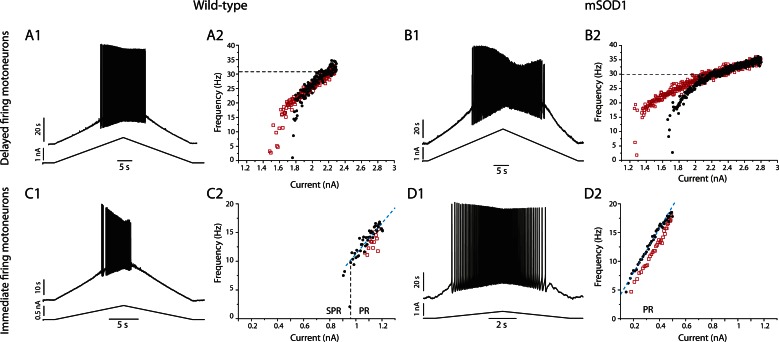
Responses of a delayed firing motoneuron (upper row) and of an immediate firing motoneuron (lower row) to a slow current ramp.Same motoneurons as in Figure 7. (A1–A2) WT delayed firing motoneuron. (A1) Bottom: injected-current (slow triangular ramp at the 0.1 nA/s velocity) and top: voltage-response. (A2) F–I curves for the ascending (black dots) and descending ramps (red squares). Note that the recrutement current occurs at higher intensity than the de-recruitment current. (B1–B2) mSOD1 delayed firing motoneuron. In A2 and B2 the dashed horizontal line points to the frequency reached during the ascending phase (black dots) 0.5 s after the motoneuron has started to discharge. These frequencies are 28 Hz for the WT delayed firing motoneuron in A2 and 30 Hz for the mSOD1 delayed firing motoneuron in B2. (C1–C2) WT immediate firing motoneuron. The vertical dashed line is the separation between the subprimary range in which MMOs are present and the primary range (PR) in which MMOs are absent during the ascending ramp. The oblique blue dashed line is the linear regression in the primary range. Its slope (29 Hz/nA) is the gain. (D1–D2) mSOD1 immediate firing motoneuron. MMOs are absent, there is only a primary range (PR) during the ascending ramp (gain: 41 Hz/nA).